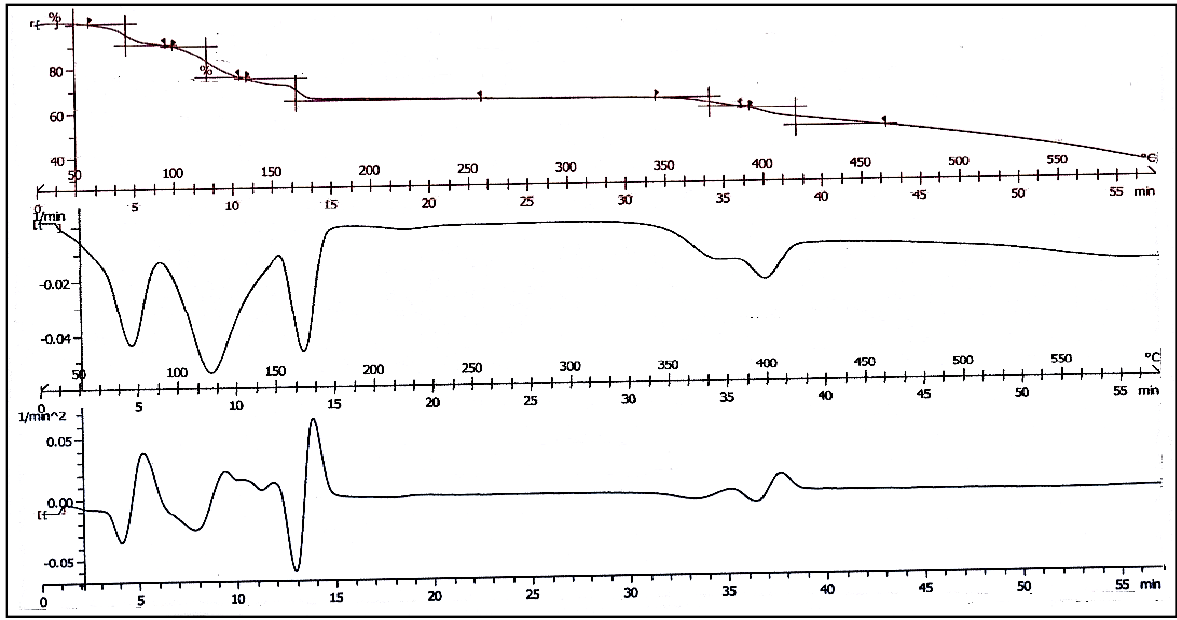
Figure 4. Thermogram of C-5-bromo-2-hydroxyphenylcalix[4]-2-methylresocinarene ( I